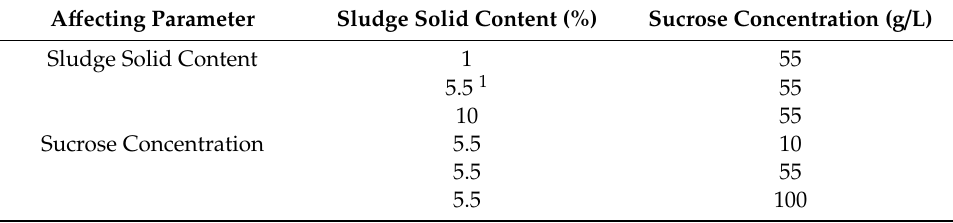
Table 1. Design of experimental conditions in this